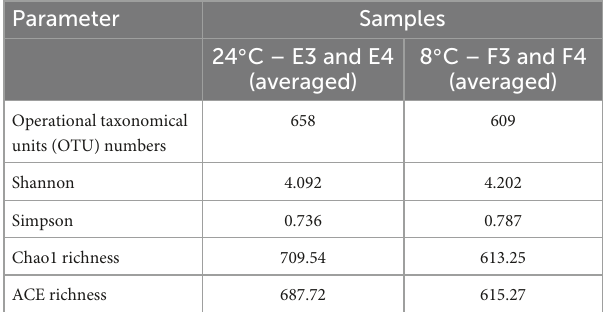
TABLE 2 Alpha diversity analysis index at 97% clustering